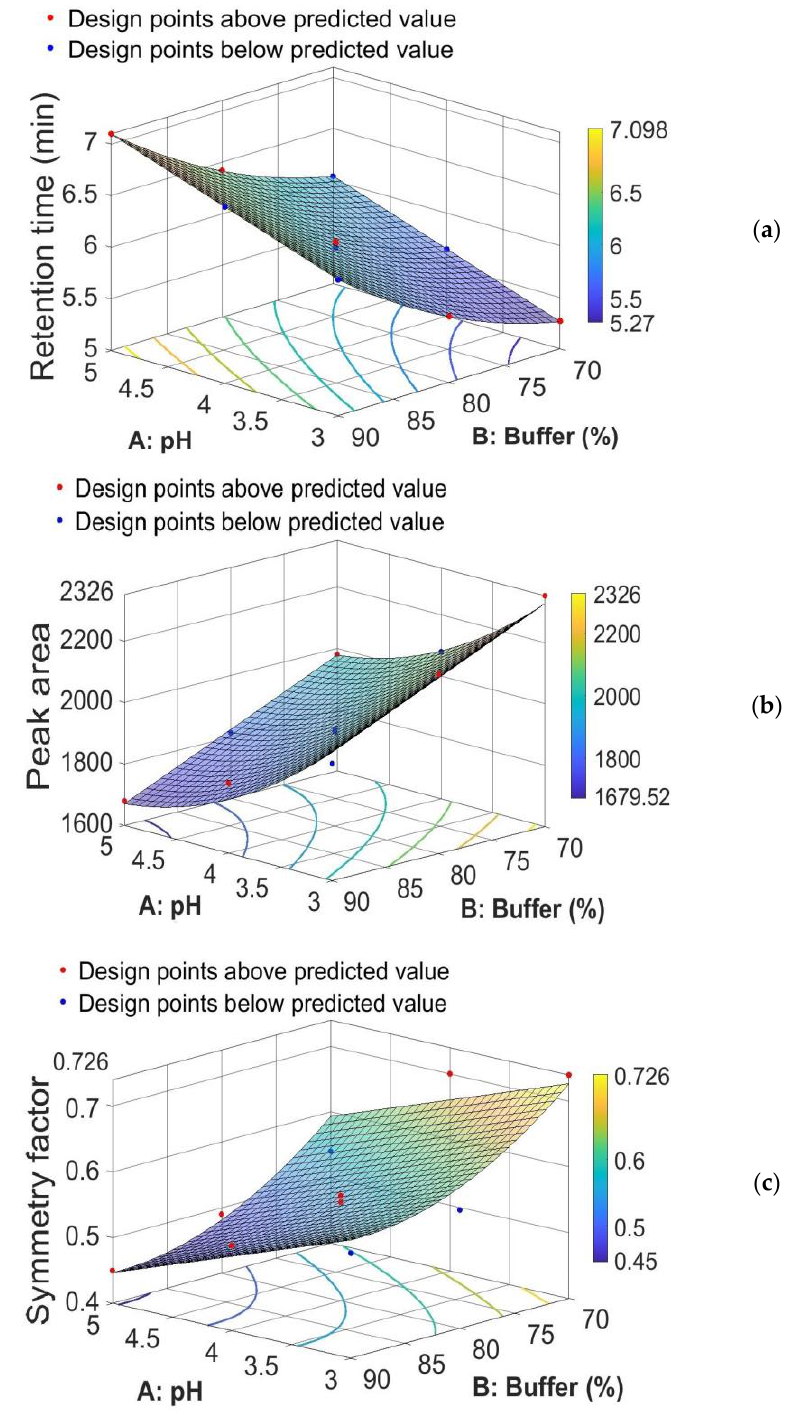
Figure 4. Three-dimensional (3D) response surface plot for ( a ) retention time, ( b ) peak area, and ( c ) symmetry factor, showing effect of % of buffer and pH in the mobile phase.